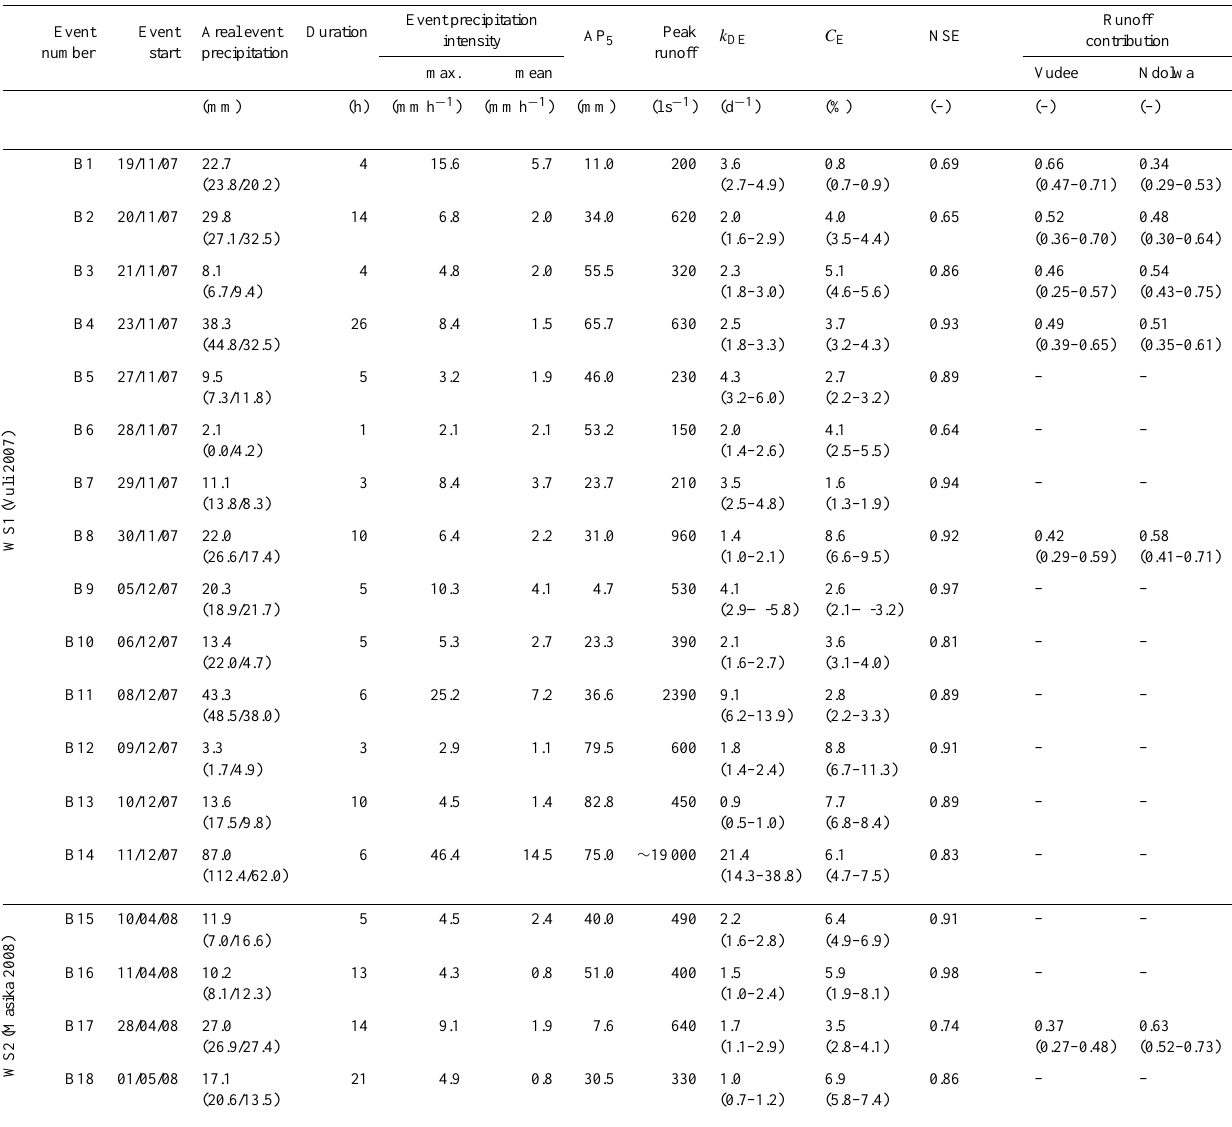
Table 2. Event summaries for the Bangalala catchment (B1–B18). Event precipitation is the average catchment precipitation, the values in brackets show the event precipitation in the Vudee and Ndolwa sub-catchments. AP 5 represents the total precipitation of the preceding 5 days, k DE is the event storage coefficient and RC E is the event runoff coefficient. The values in the brackets show the 95% uncertainty interval. Values of peak runoff measured at Bangalala